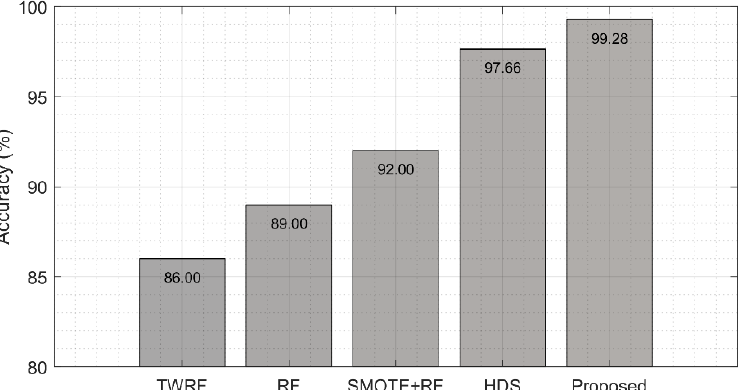
Figure 6. Comparison of results with previous studies. Our proposed model is compared with a three-way random forest classifier (TWFR) approach [27], Random Forest (RF) [67], SMOTE + RF [68], and a Hybrid Fuzzy inference engine and deep neural network (HDS) [66].